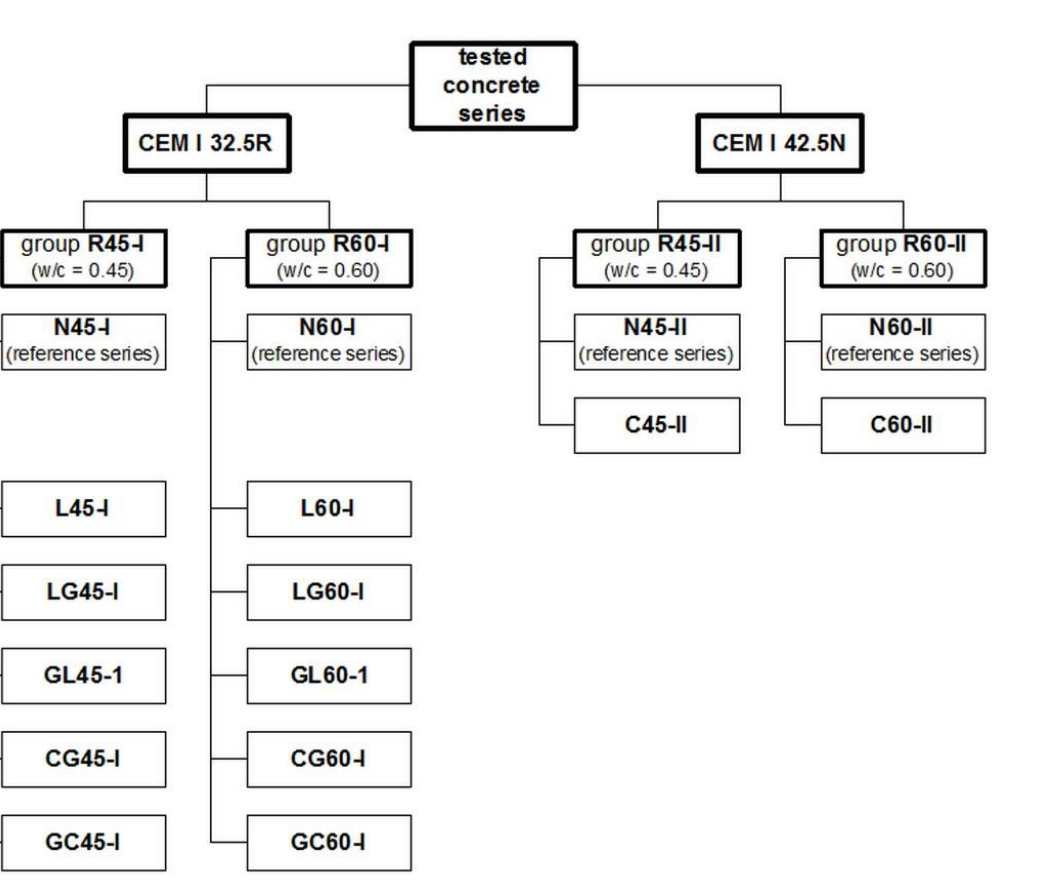
Figure 1. The schematic presentation of the research plan.